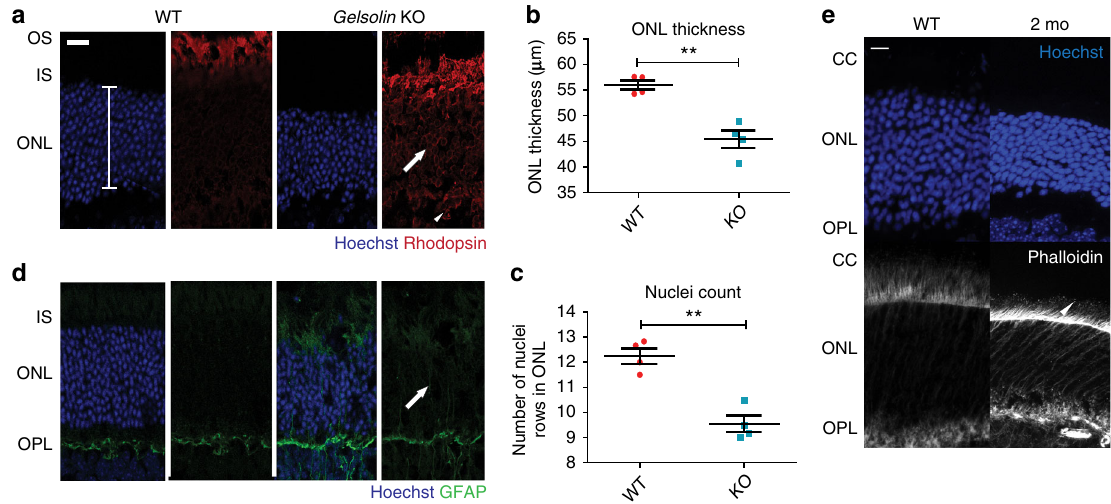
Fig. 5 Knockout mouse studies con fi rm a role for Gelsolin in photoreceptor maintenance. a – c Outer nuclear layer (ONL) degeneration develops in the gelsolin knockout mouse at 5 months of age ( a ; bracket represents ONL length measured); signi fi cant for ONL thickness ( b ; n = 4, Figures denote mean ± SEM, unpaired two-tailed t -test, ** = p < 0.01) and rows of nuclei ( c ; n = 4, Figures denote mean ± SEM, unpaired two-tailed t -test, ** = p < 0.01). As in the Rpgr -KO mouse shown in Fig. 3, rhodopsin is mislocalised to the outer plexiform layer ( arrowhead ; a ) and peri-nuclear area ( arrow ; a ). d Increased GFAP immunolabeling throughout the radial length of Müller cells in the ONL is apparent ( arrow ) at 5 months of age. e Increased F-actin is seen in the connecting cilium ( arrowhead ) of Gelsolin KO mouse photoreceptor compared to wild-type. (Images representative of n = 3 analysed). Scale bars : 20 μ m a ,